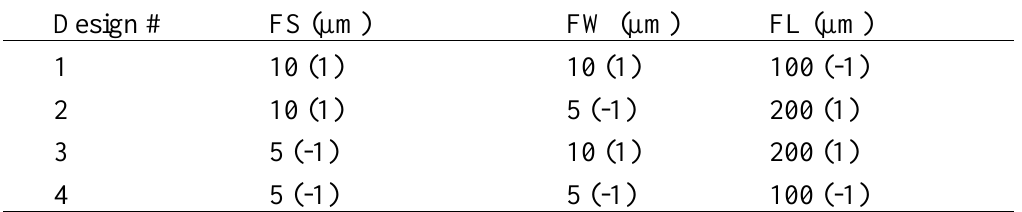
Table 1. Design parameters based on 2 3-1 fractional factorial experimental design of IMEs.